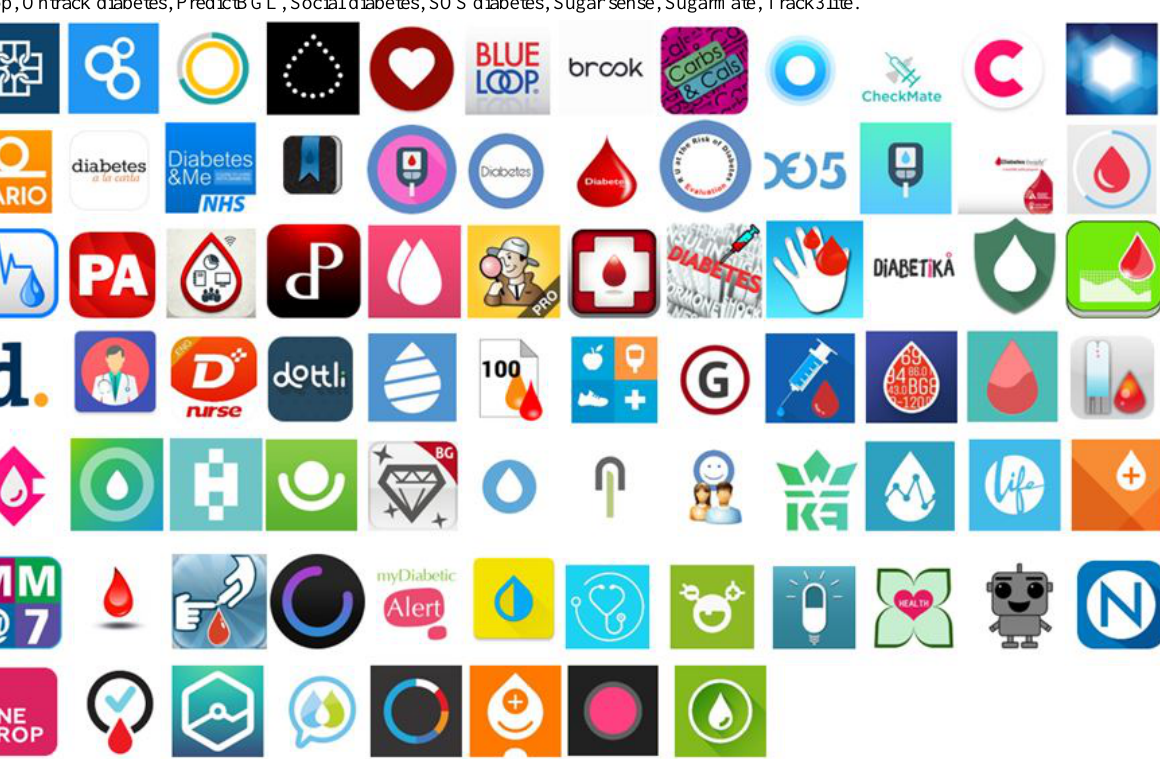
Figure 4. Apps included in the analysis. From top-down left-right: Balansio, Bant, BeatO, Beyond type 1 diabetes, Blood glucose tracker,